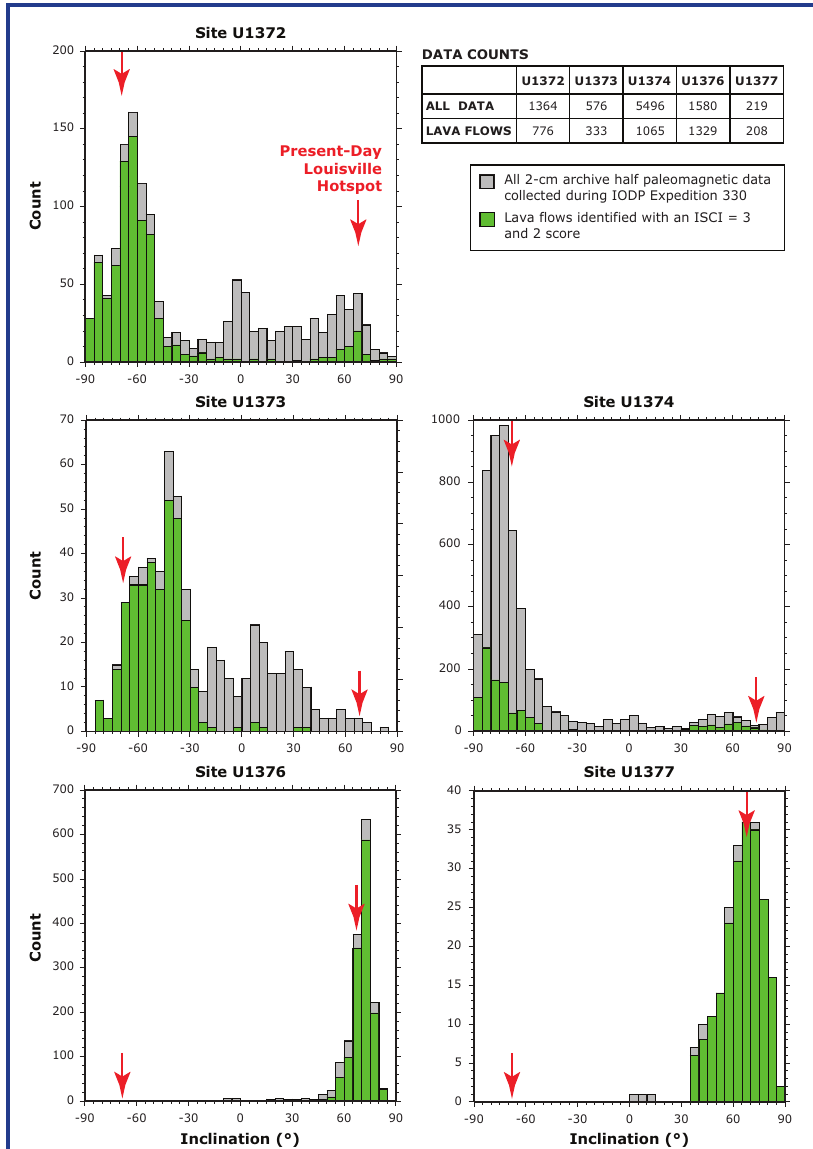
Figure 8. Compilation of inclination histograms for measured 2-cm archive half data. All high-quality data (see red symbols in Fig. 7) are plotted in gray, while the highly probable in situ lava flow units are indicated in green. We note that the gray histograms include lava flow and volcaniclastic/sedimentary units. Total numbers of observations are listed in the table in the top right corner, whereas the red arrows indicate the present-day inclination value for the Louisville hotspot at 51°–52°S latitude. Figure after Koppers et al.